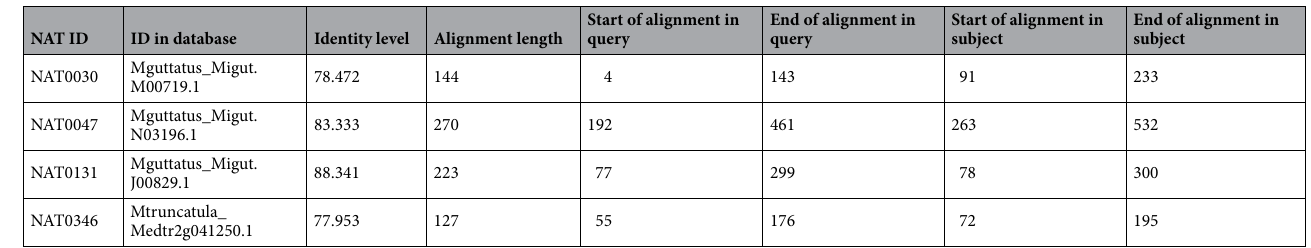
Table 1. List of conserved NATs identified in S. miltiorrhiza